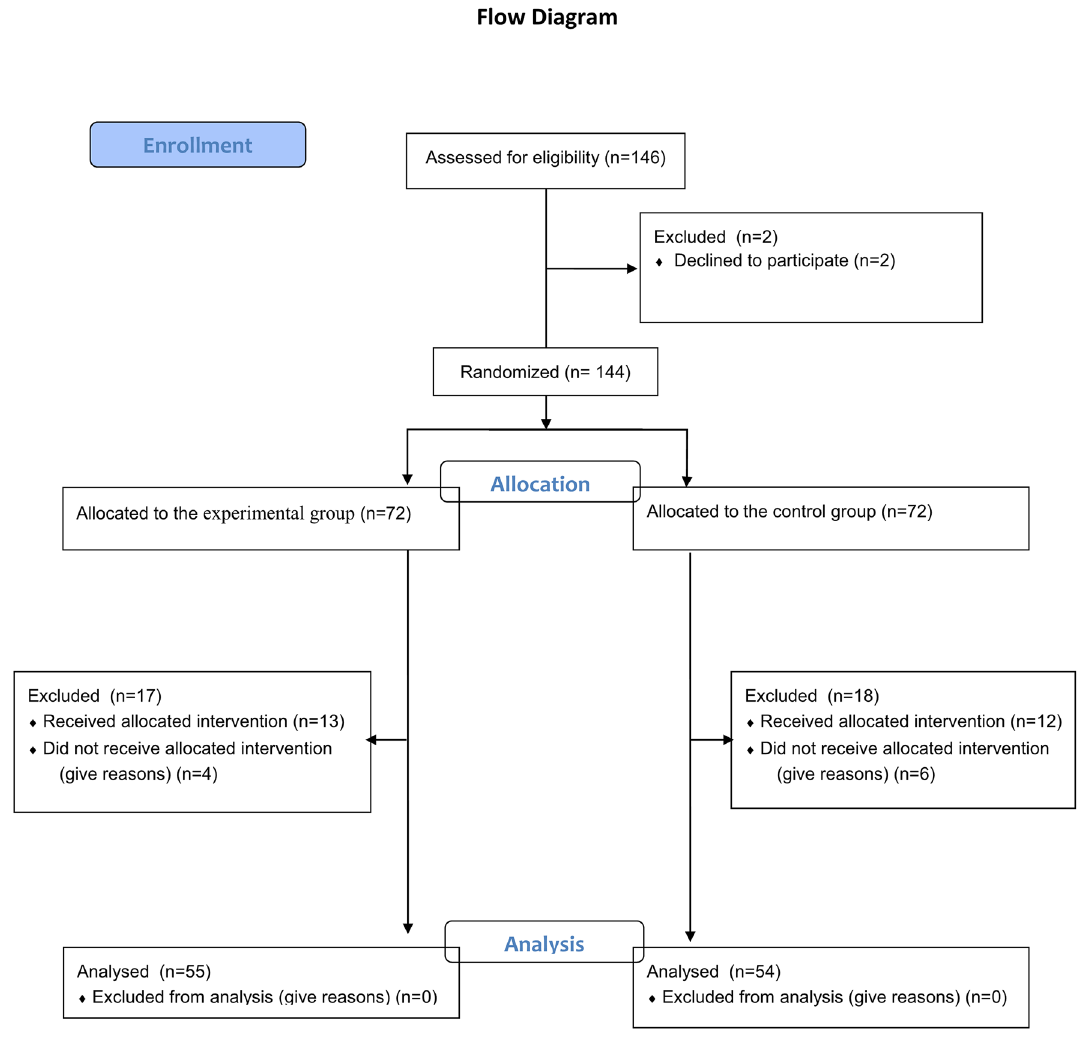
Figure 2. CONSORT flow